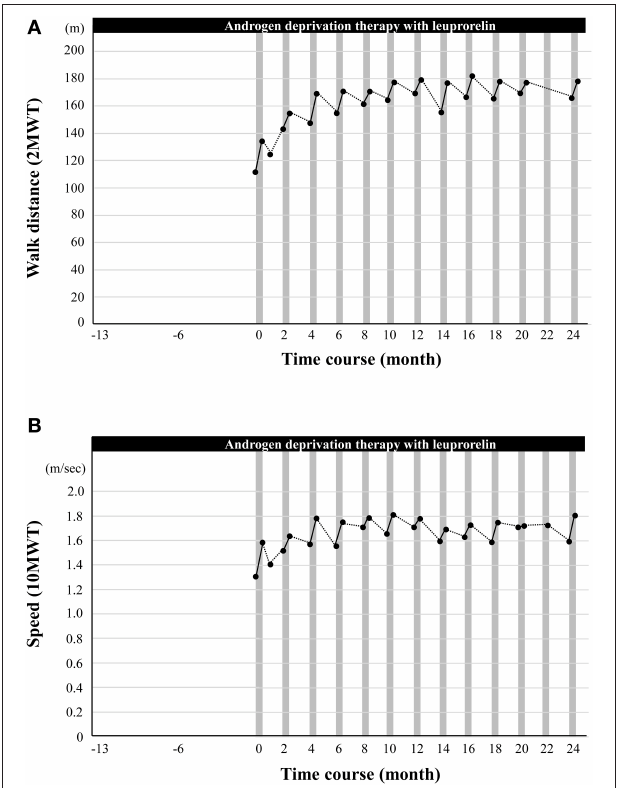
FIGURE 2 | The effect of cybernic treatment with a hybrid-assisted limb (HAL) on gait function. (A) The black dots indicate the measured walk distance (a 2-min walk test, 2MWT). (B) The black dots indicate the speed (a 10-min walk test, 10MWT). Vertical gray bars indicate one course of cybernic treatment with HAL.